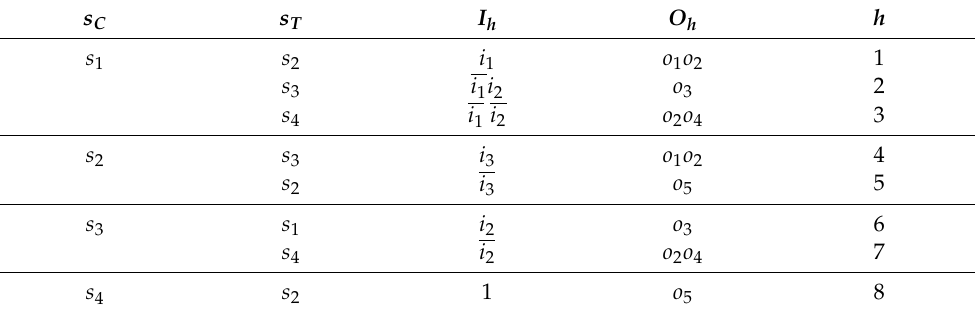
Table 1. State transition table (STT) of Mealy finite state machine (FSM) A 1 . s C s T I h O h h s 1 s 2 i 1 o 1 o 2 1 s 3 i 1 i 2 o 3 2 s 4 i 1 i 2 o 2 o 4 3 s